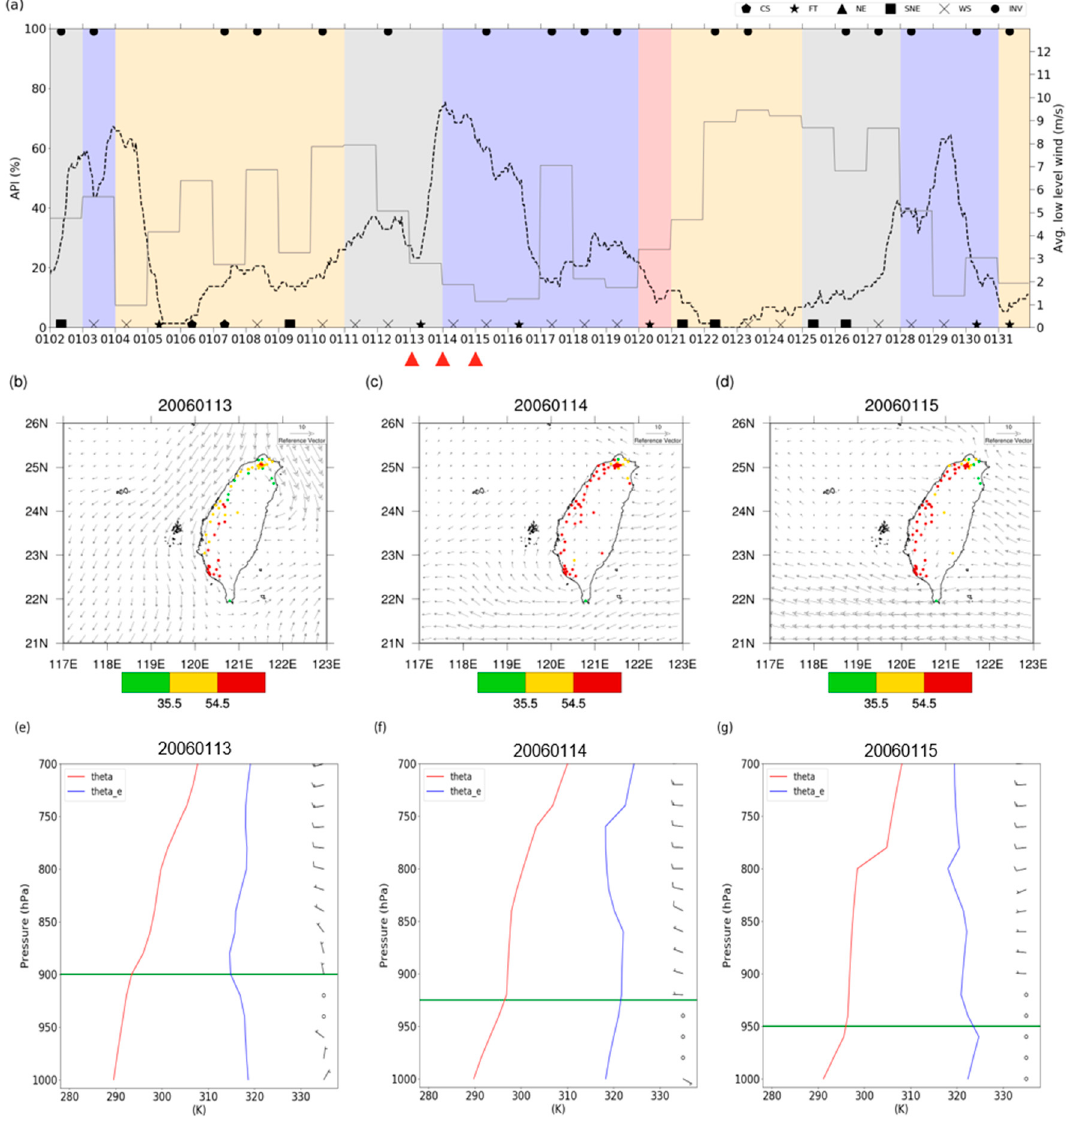
Figure 5. The case study for January 2006. ( a ) API time series (dashed line), the low-level wind speed averaged over the surface to 925 hPa (thin line), the near-surface temperature inversion around boundary layer top (black dot), and weather event (black symbols) in this month. The shadings in the background represent the beginning day of the air pollution clusters (blue for C1, gray for C2, yellow for C3, and pink for C4). The red triangles on the x -axis mark the High API episode through the 13th to the 15th. ( b – d ) are the daily mean PM 2.5 concentrations (color dots; units: µ g m − 3 ) and wind field on 925 hPa (vectors; unit: m s − 1 ) from the 13th to 15th. ( e – g ) are the vertical profiles of potential temperature (red line), the equivalent potential temperature (blue line), and wind (arrows) at Taipei (WMO-46692) from the 13th to 15th. The green line represents the level of temperature inversion.